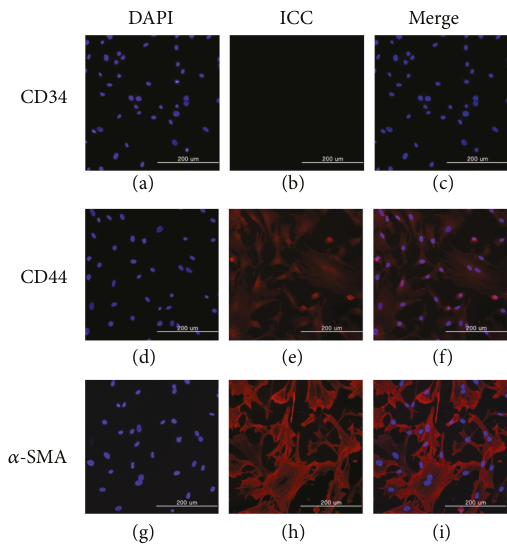
Figure 2: bMSC surface marker expression and validation by immunocytochemistry. The bMSCs were negative in CD34 (c) and positive in CD44 (f) and alpha-SMA (i). The scale bar indicates 200 μ